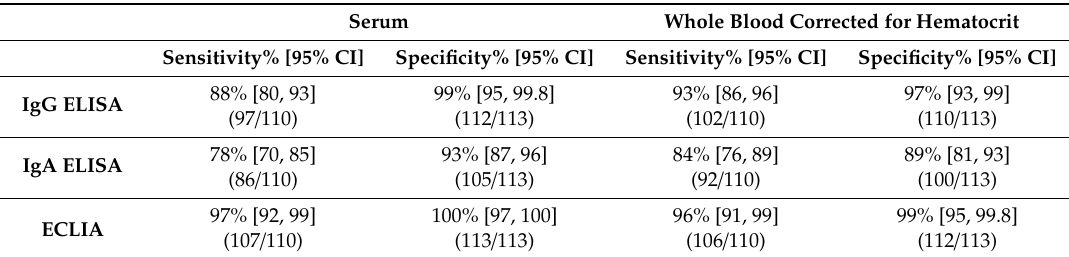
COVID-19 diagnosis. Cuto ff for the ELISAs: S / C > 1.1. Cuto ff for the ECLIA: COI > 1. Serum Whole Blood Corrected for Hematocrit Sensitivity% [95%